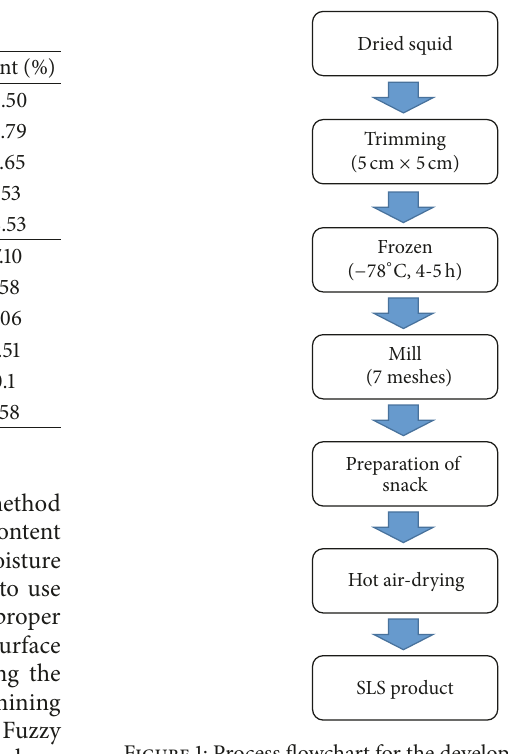
Figure 1: Process flowchart for the development of